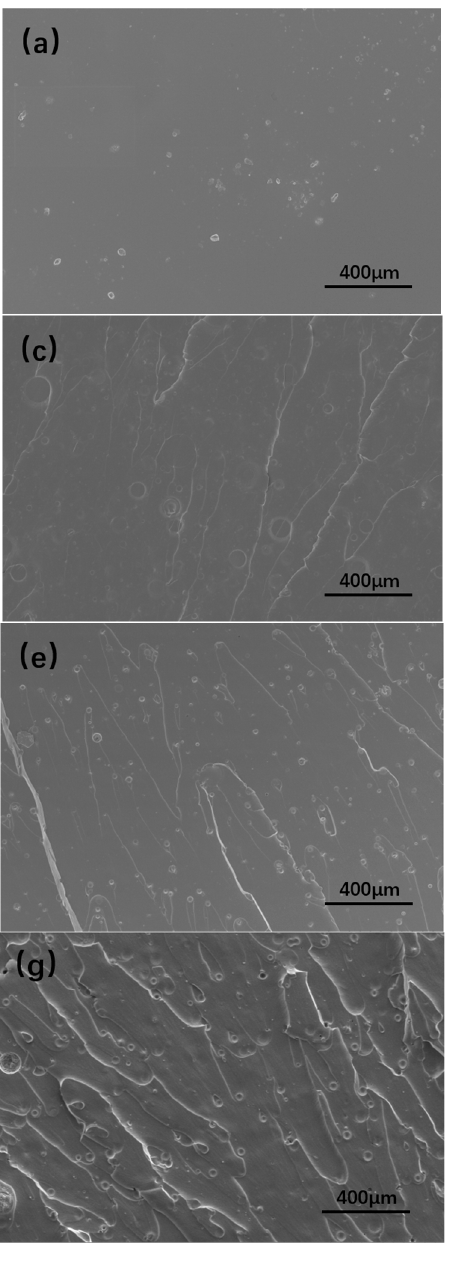
Figure 5. The SEM of tensile cross-section of polymer films with different R = 1.2 ( a ), 1.4 ( b ), 1.6 ( c ), 1.8 ( d ), 2.0 ( e ), 2.2 ( f ), 2.4 ( g ), and energetic polymer composites with 40% RDX with R = 2.2 ( h ).